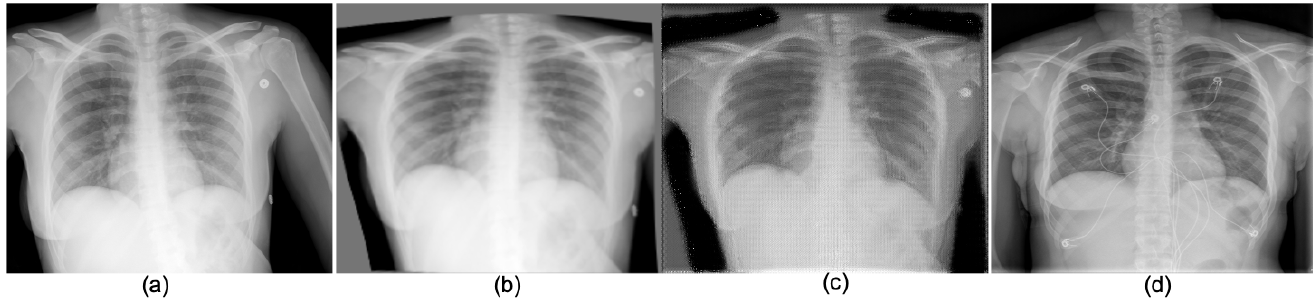
Figure 2. An example of an enhanced quality portable CXR, of the kind used for COVID-19 patients: ( a ) original portable CXR; ( b ) aligned CXR from ( c ); ( c ) quality-enhanced CXR from ( b ); and ( d ) a reference of high-quality CXR captured from a conventional